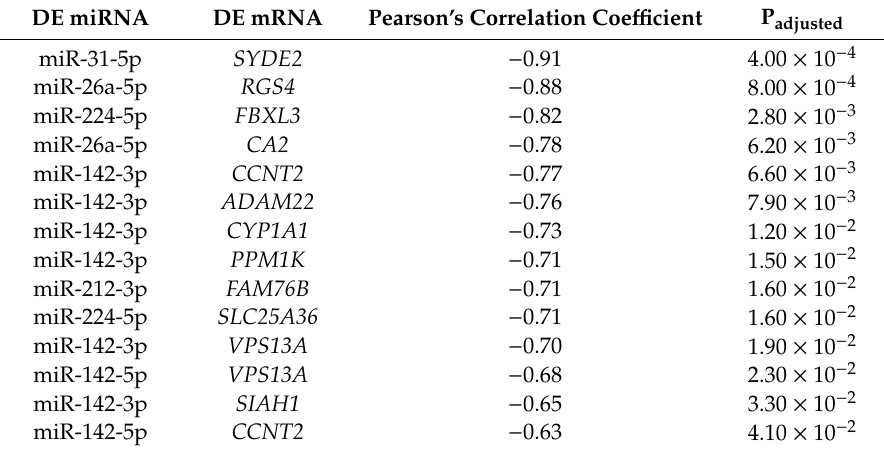
Table 11. This table displays the significantly negatively correlated miRNA-mRNA pairs for the comparison of horses in exacerbation and control horses. Pearson’s correlation coe ffi cient and P adjusted are indicated.